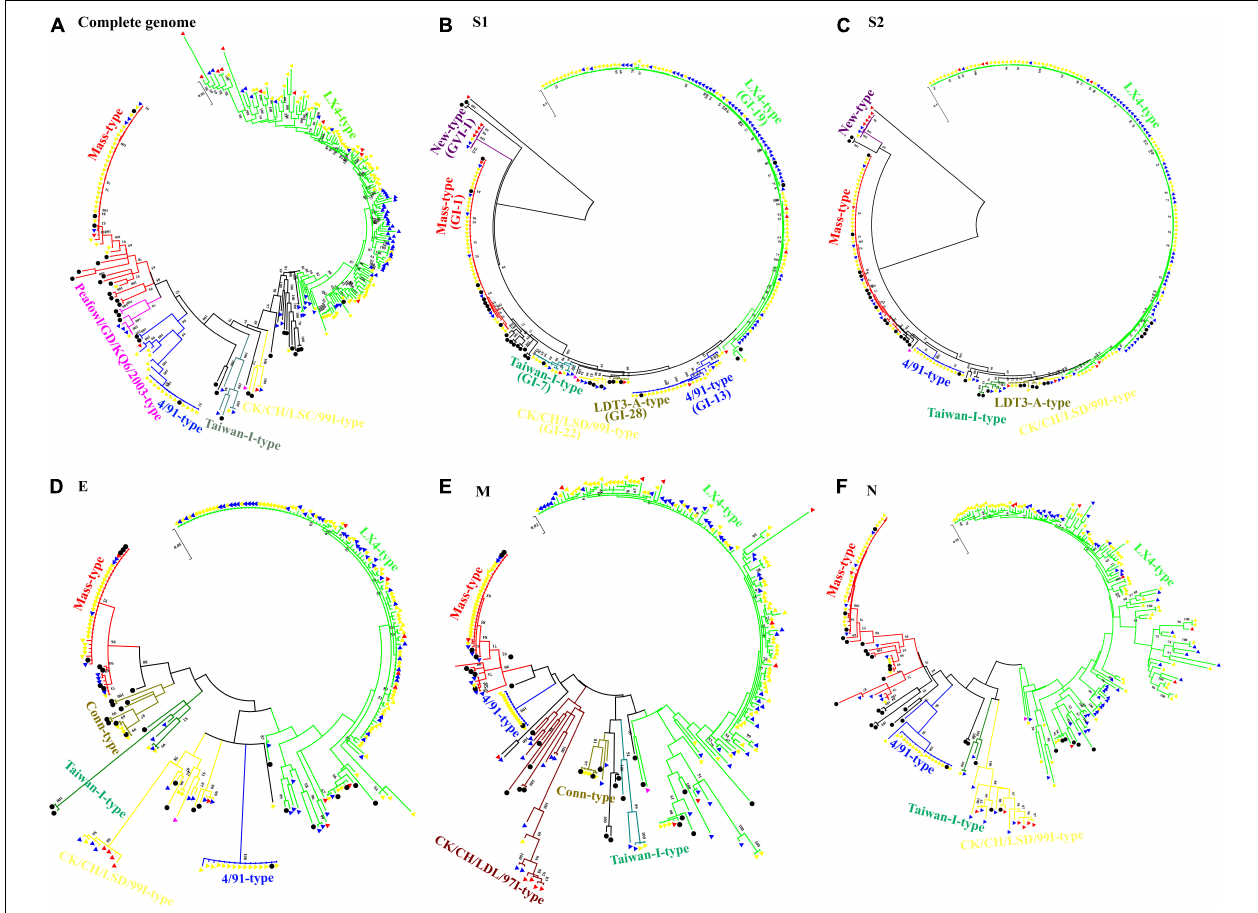
FIGURE 1 | Phylogenetic trees of the complete genome (A) and genes S1 (B) , S2 (C) , E (D) , M (E) , and N (F) of infectious bronchitis viruses (IBVs). Each type of IBV was highlighted in different colors. The 33 IBV reference strains were marked with filled • . IBV isolates isolated during 1985–1998 were marked with filled (cid:78) . The 69 IBV isolates isolated during 1999–2010 were marked with filled (cid:78) . The 128 IBV isolates isolated during 2011–2014 were marked with filled (cid:78) , and the 14 IBV isolates isolated during 2015–2020 were marked with filled (cid:78) . Phylogenetic trees were constructed with the maximum likelihood method using MEGA version 6.06. The bootstrap clade support values were computed based on 1,000 bootstrap replicates. The number represents the percentage of times that the clade appeared in the bootstrap tree distribution. Bootstrap values greater than 50% are